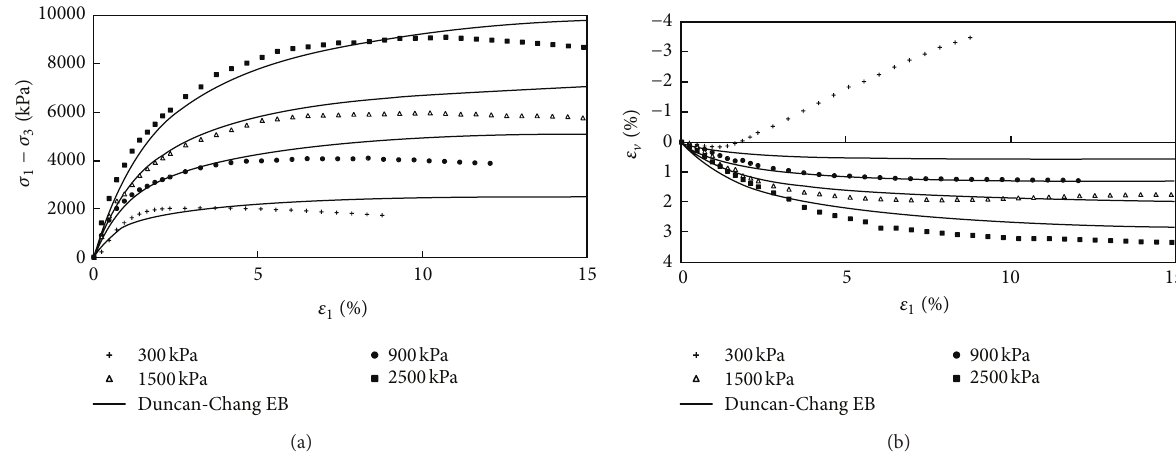
Figure 4: Comparison between fittings of Duncan and Chang’s EB model and experimental triaxial tests results for rockfill material